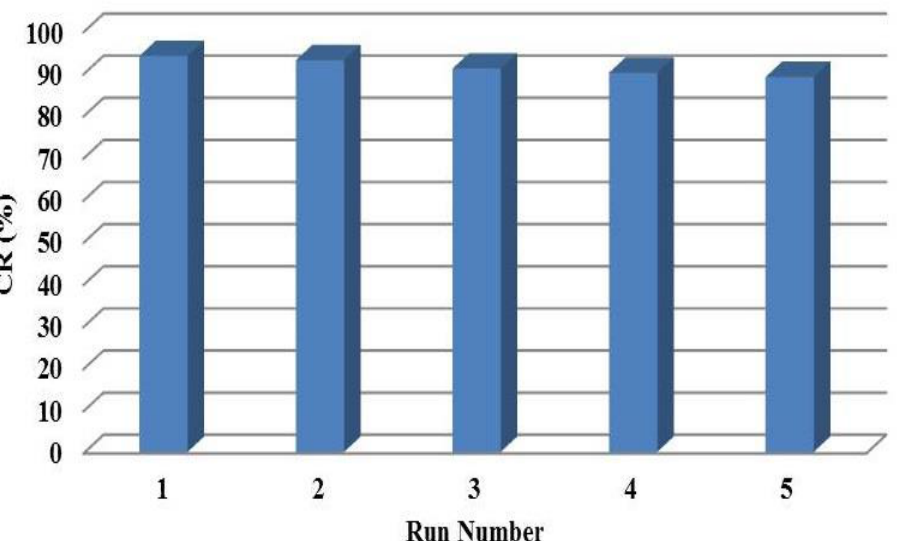
Figure 13. Reusability of the diatomite coated 6% Dy-doped yttrium oxide nanostructures within five continuous experiments. The ultrasonic power = 120 W/L, [Catalyst] 0 = 1.25 g/L, [RB 19]0 = 20 mg/L, pH=6.5 and the reaction time = 70 min